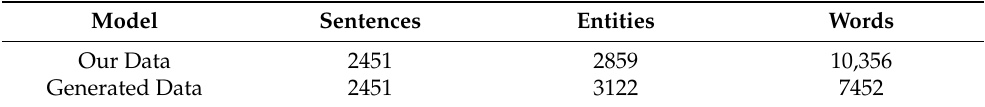
Table 7. Data diversity